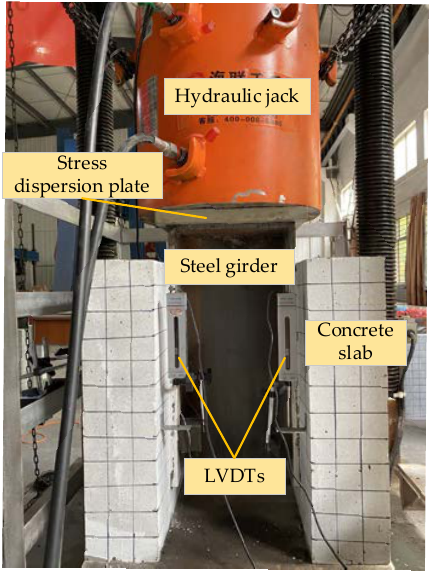
Figure 2. Test setup and